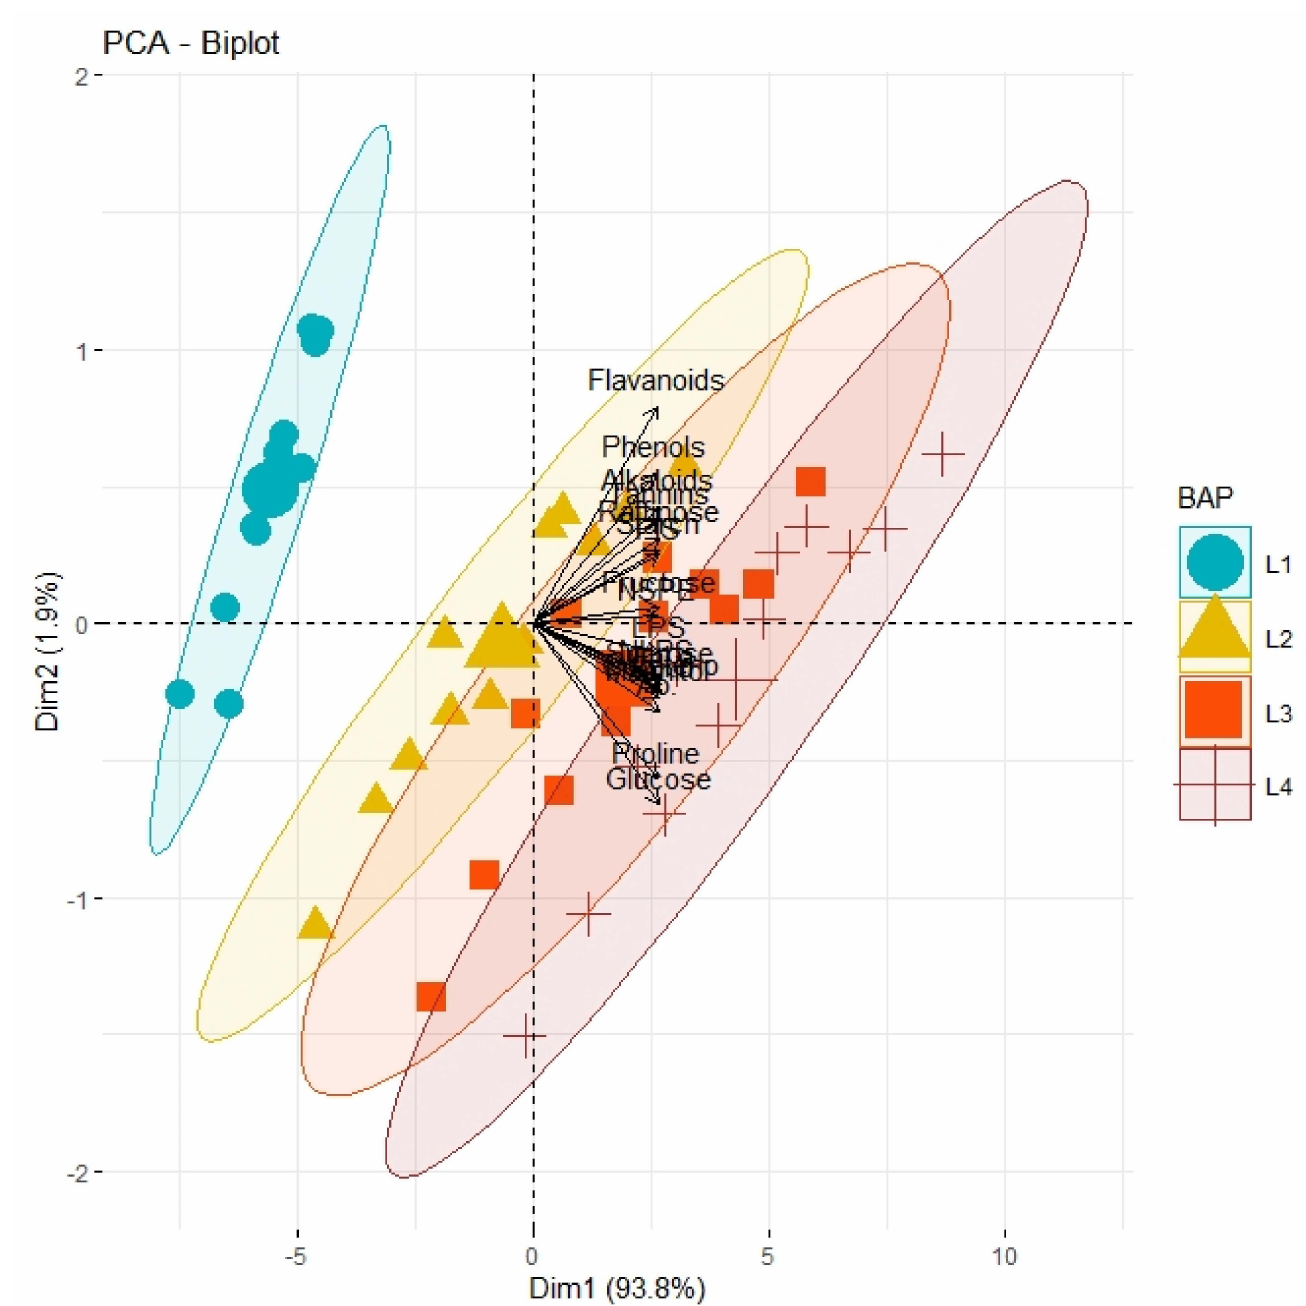
Figure 1. PCA graph demonstrating the extent of association and divergence of physiological, biochemical, and growth-related traits of different olive genotypes from origin under varying concen- trations (L1, control; L2, 0.5 mgL − 1 ; L3, 1.5 mgL − 1 ; L4, 2.5 mgL − 1 ) of BAP with respect to